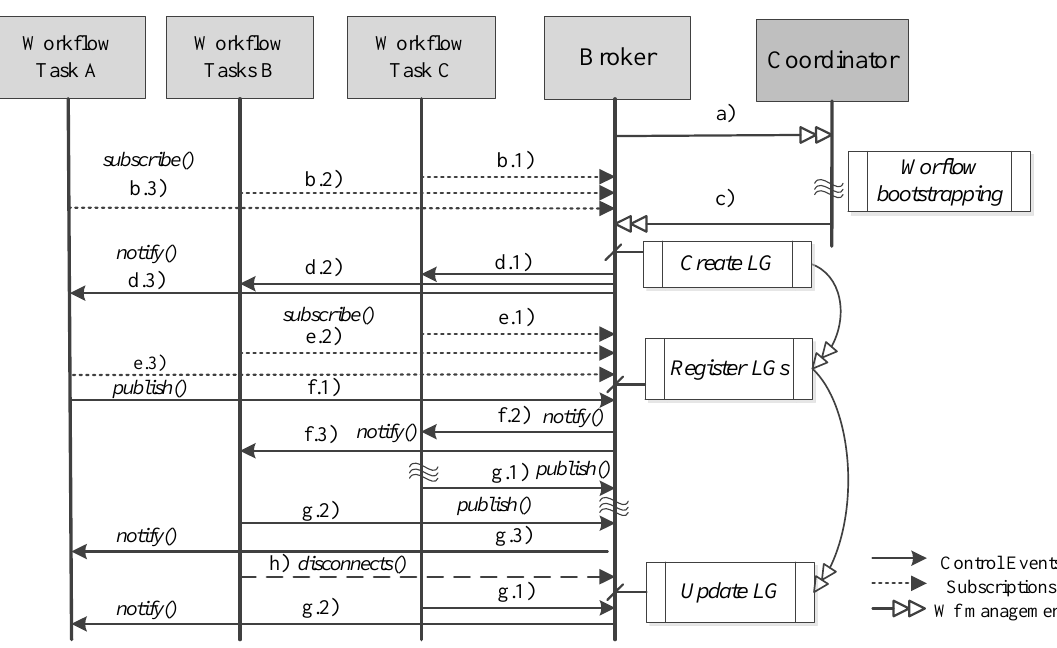
Figure 6. Workflow